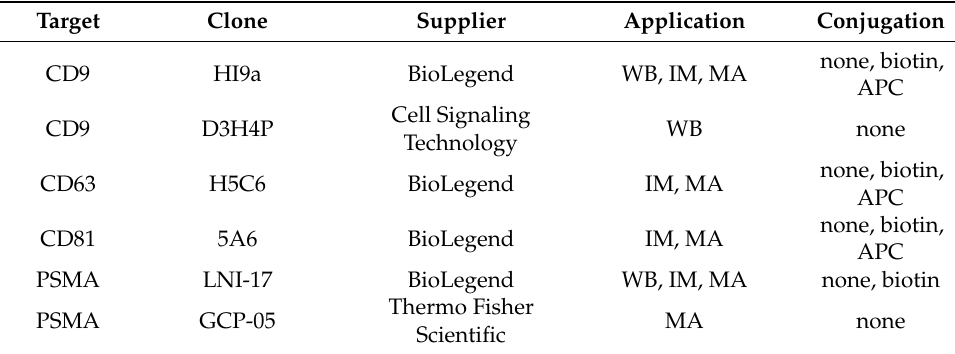
Table 1. Antibodies and their clone ID and conjugation used for Western blot (WB), immunomagnetic isolation (IM), or antibody microarray